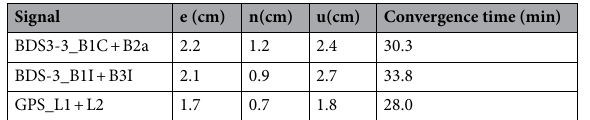
Table 8. Average of positioning errors RMS and convergence time over all observation stations for